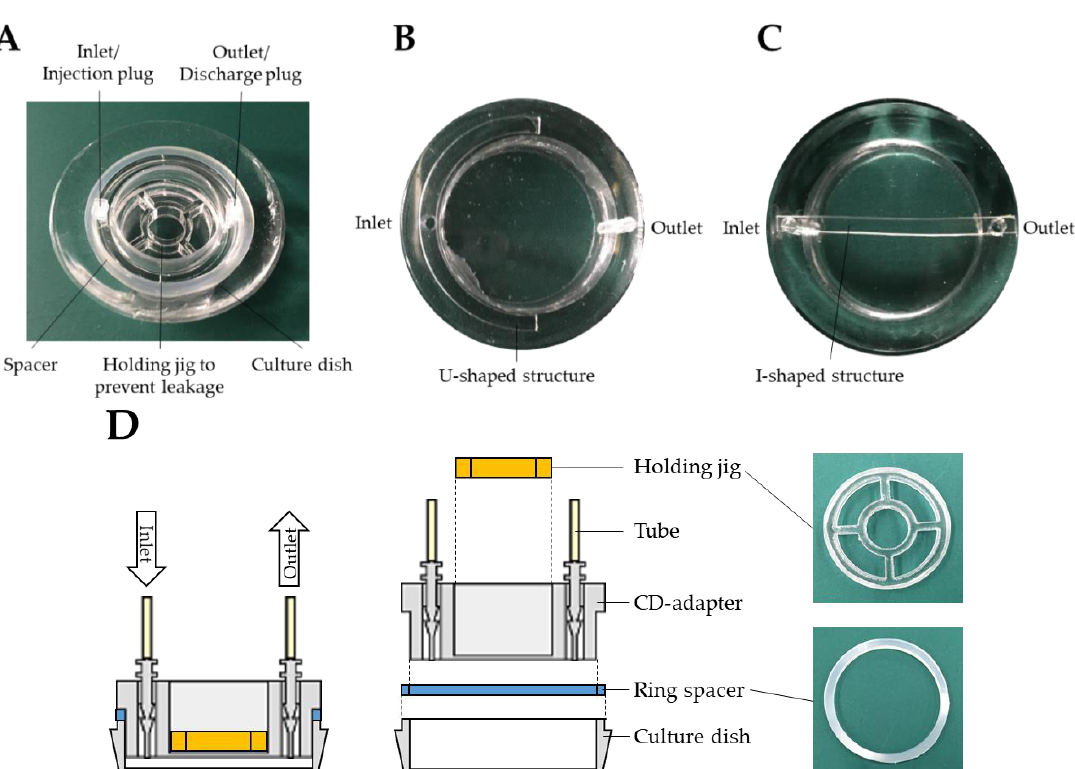
Figure 3. The fabricated CD-adapter with its small recess structure. ( A ) A CD-adapter compatible with 35-mm culture dishes. Because it is fabricated with polydimethylsiloxane (PDMS), it is highly transparent and enables cell observation by microscope. In addition, owing to good air permeability, it can supply enough oxygen to cells even in a sealed state. A plug was inserted into both inlet and outlet to connect to the tube, and the amount of medium in the culture dish can be adjusted by raising the adapter with a spacer. Furthermore, a holding jig to prevent liquid leakage was fitted in the center of the adapter, and pressure is applied from the inside toward the culture dish to increase adhesion between the adapter and the culture dish. ( B ) Small recess structure created on the bottom of the CD-adapter used in this work. A horseshoe-like small recess structure spreads from the inlet side to the equatorial line in the bottom. The width of the groove was 2.0 mm and its depth was 500 µm. ( C ) Small recess structure created on the bottom of the CD-adapter used in this work. A linear small recess structure extends from the inlet side to the outlet side. The width of the groove was 2.0 mm and its depth was 500 µm. ( D ) Procedure for setting the CD-adapter to the culture dish. A ring spacer of 2 mm thickness made of silicon was placed between the culture dish and the CD-adapter to raise the adapter and make cell culture space. A holding jig was fitted in the center of the adapter to prevent liquid leakage.